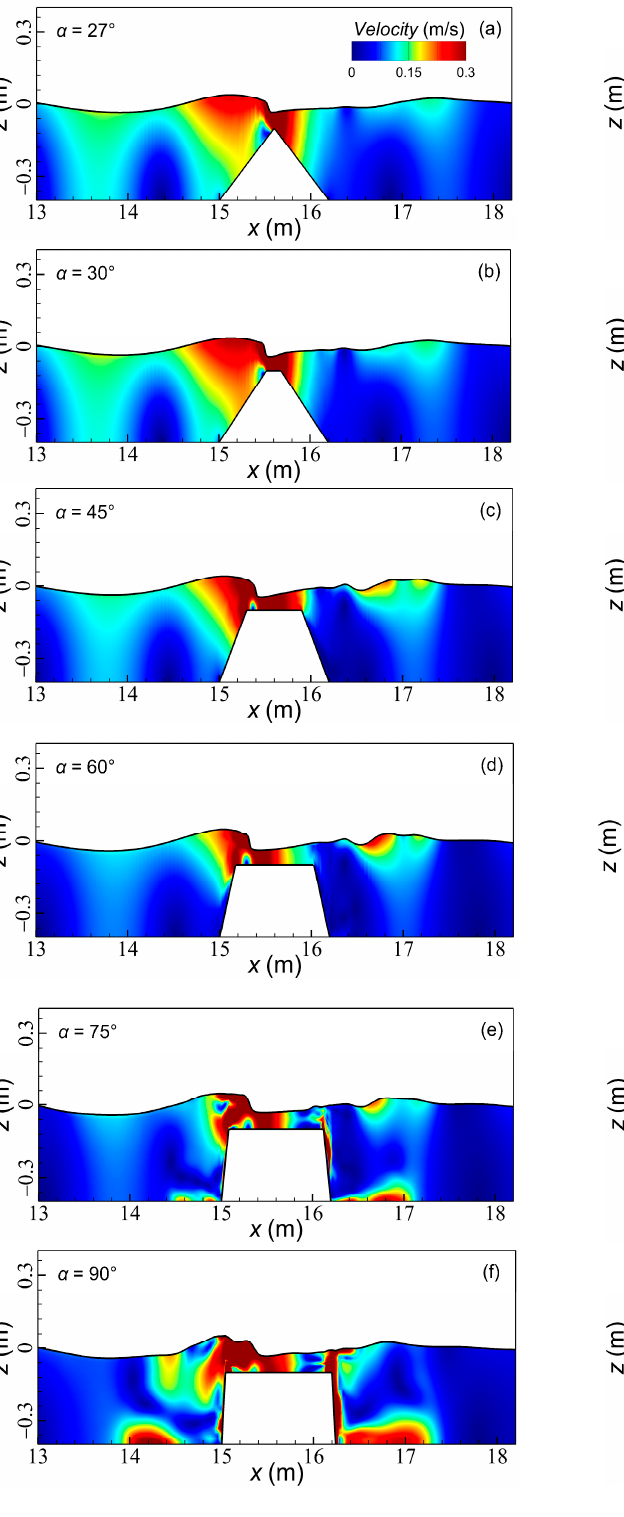
Figure 23. Snapshots of the water velocity contour with different side slopes of the breakwater; left side ( a – f ): submerged impermeable breakwater; right side ( g – l ): submerged permeable breakwater.